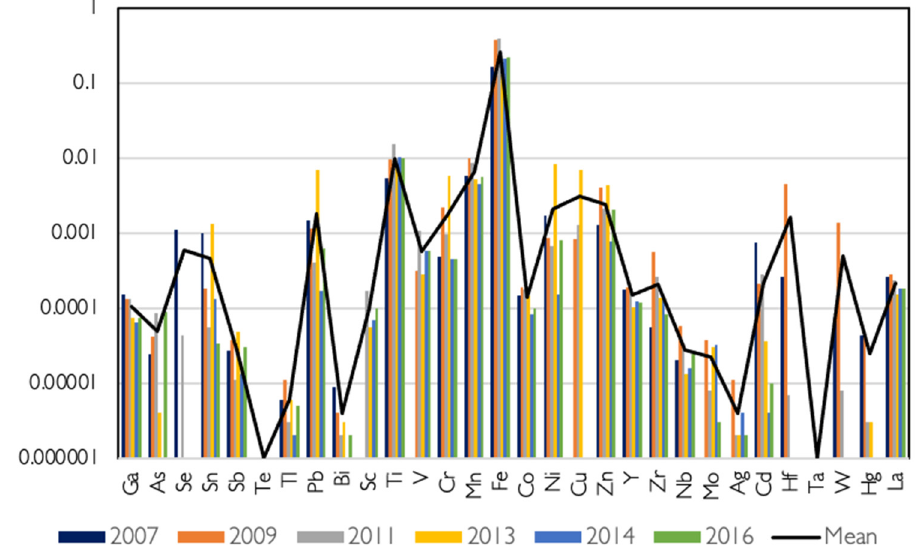
Figure 13. The same as at Figure 12 but for regional and local distribution. The elemental composition of aerosols is closest to the composition of fine and me- dium dust (particles 1–10 μ m in size (diameter)) of sandy soil (correlation coefficient R = 0.73), differing from the composition of soils of dry steppe (R = 0.69) and Solonchaks (R = 0.50). Having studied the chemical composition of sandy soils and aerosol particles in the surface layer of arid zones of Kalmykia, we have revealed that the predominant fraction in the soil is the fraction of fine sand (86.6%), significantly exceeding the percentage of fractions of silt, medium and coarse sand. The chemical composition of the sand sample is aluminum-silicon. The amount of silicon oxide exceeds 80%, aluminum—10%. The amount of iron oxide is only 2.5%, calcium—2.2%. Alkaline earth elements are − 1.5% cal- cium oxide and 1.8% magnesium oxide. The predominant fraction for the main microele- ments of aerosol particles is the fraction of fine sand (1–5 μ m), the fraction of sludge by